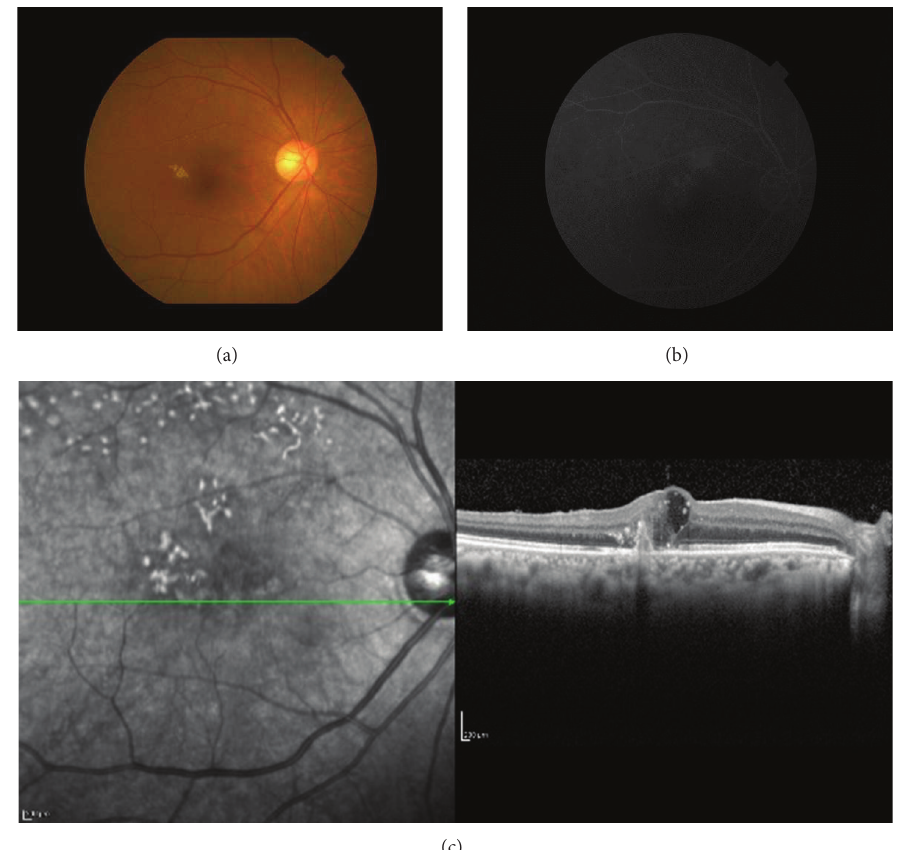
Figure 1: Finding of the right eye of Patient 1 with idiopathic macular telangiectasis (MacTel) type 1 on her first visit. Her best-corrected visual acuity (BCVA) was 20/100. (a) Fundus photograph showing hard exudates associated with telangiectasia temporal to the fovea. (b)Fluorescein angiogram showing strong fluorescein leakage in the late phase. (c) Optical coherence tomographic (OCT) image showing cystoid macular edema in the area surrounding the